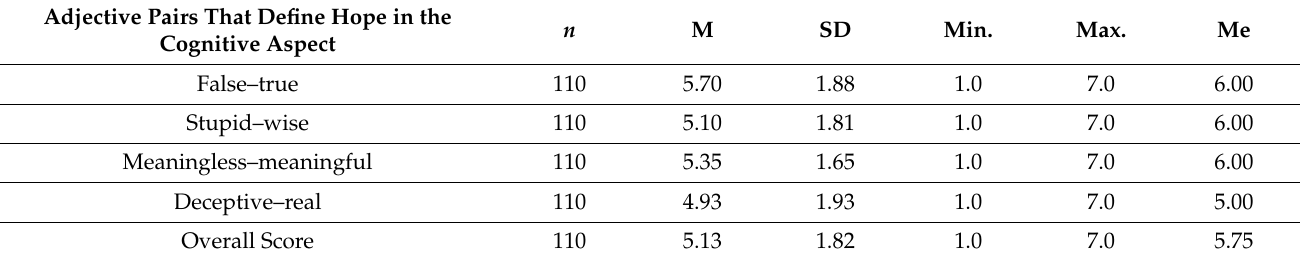
Table 3. Perception of the meaning of hope in the cognitive aspect by the surveyed men in the semantic space measured with the DSN-3 test—descriptive statistics.